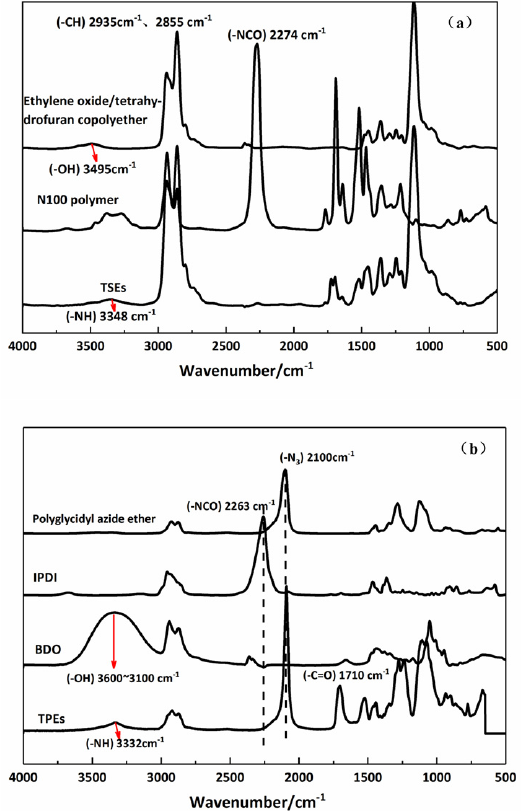
Figure 3. FTIR spectra confirm the forming of TSEs and TPEs. ( a ) TSEs reacting ethylene oxide/tetrahydrofuran co-polyether –OH with N100 –NCO polymer; ( b ) TPEs reacting poly(glycidyl azide ether) –OH with IPDI-NCO compound and BDO –OH compound.